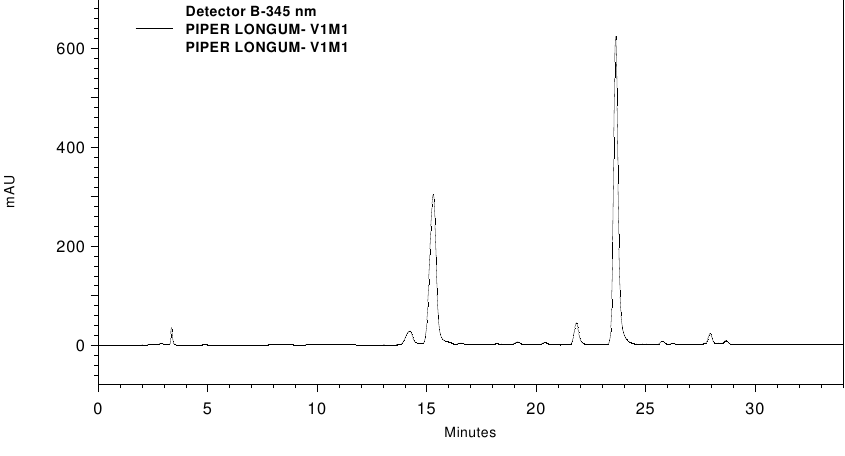
Figure 4 . HPLC chromatogram of fruit of Piper nigrum